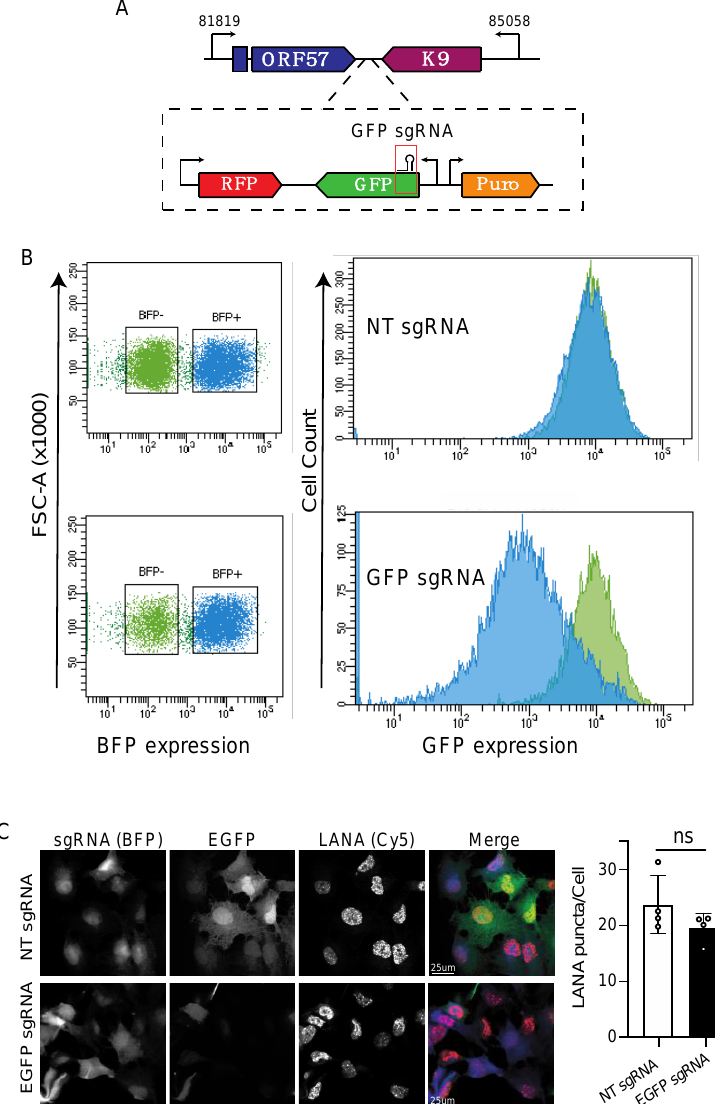
Figure 2. CRISPRi silencing of KSHV-encoded EGFP. ( A ) Region of the viral genome encoding EGFP and position of the sgRNA. ( B ) Flow cytometry analysis (MFI) of iSLK-219-dC9K cells transduced with sgRNAs targeting EGFP or non-targeting (NT) sgRNAs. Note the downregulation of EGFP expression in cells transduced with the targeting sgRNA. ( C ) Immunofluorescence and confocal microscopy analyses of paraformaldehyde-fixed, BFP expressing cells (sgRNA), EGFP and LANA in iSLK-219-dC9K cells transduced with sgRNAs targeting EGFP or non-targeting (NT) sgRNAs. Quantification of LANA puncta/Cell in four independent fields ( t -Test, ns p = 0.15).